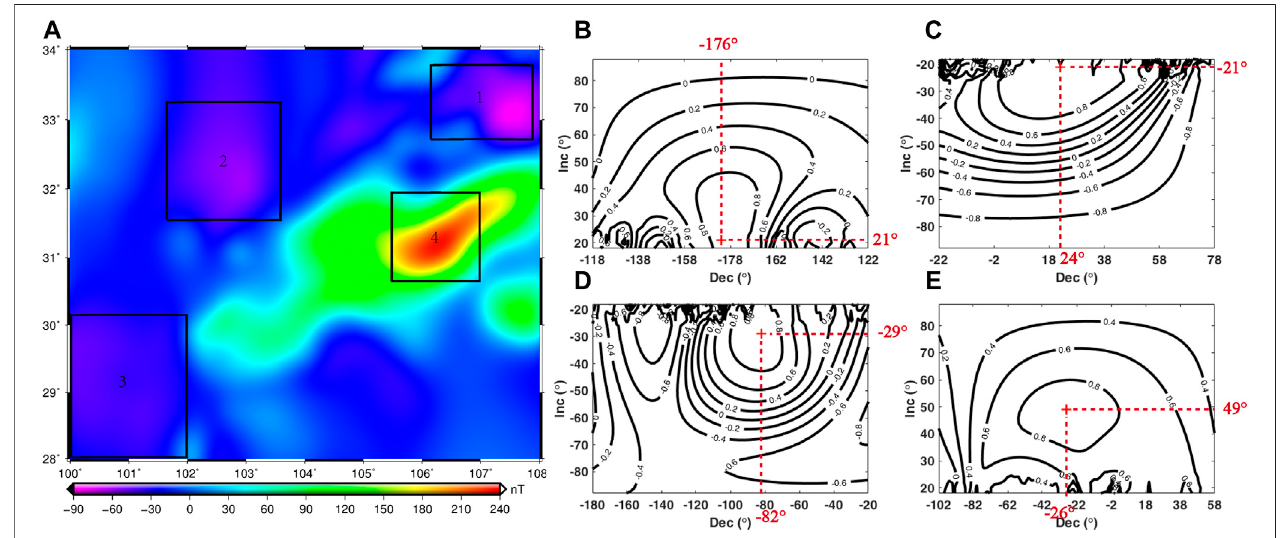
FIGURE8|(A) Regional magnetic anomalyused todeterminethetotal magnetization directionsaremarkedbyfour blackboxes. (B – E) show thecontour mapsof correlation coef fi cient between analytic signal and vertical derivative in the block 1 – 4. The most possible magnetize directions are marked by the red crosses, and the inclination and declination are shown by red